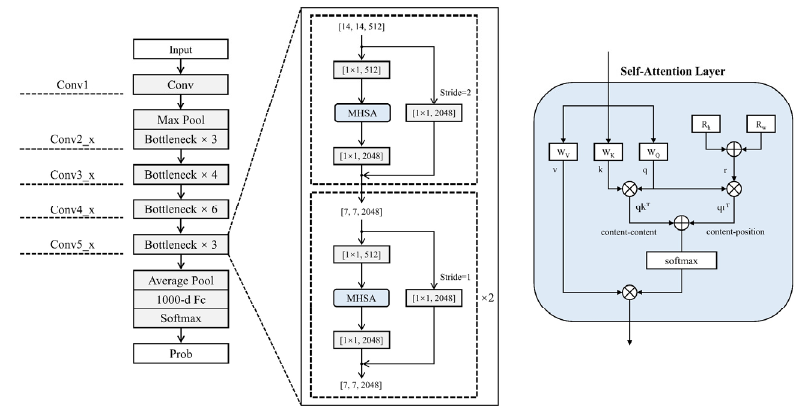
Figure 5. BoTNet network structure.